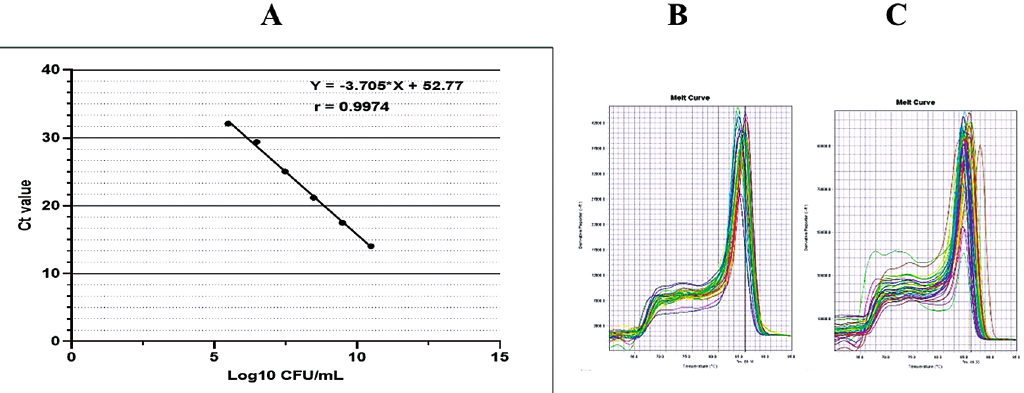
Figure 1. Standard curves and melt curves. Standard curve of C. albicans ATCC 10231 (A) and representative melt curve graph for C. albicans count in saliva (B) and tongue surface (C) all participants (DG, NDG, and control/ n = 29). The standard curve was linear as indicated by a linear correlation (r 2 ) of 0.9974 between the cycle threshold (Ct) value and template concentration, and a slope of